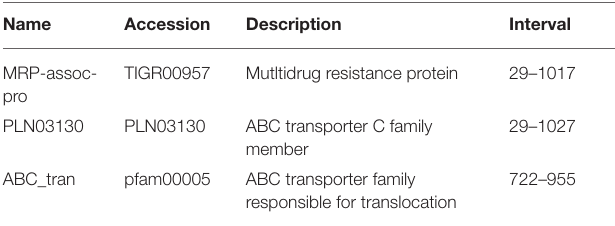
TABLE 2 | Putative functions of ABCT31 analyzed by Pblast and CDD